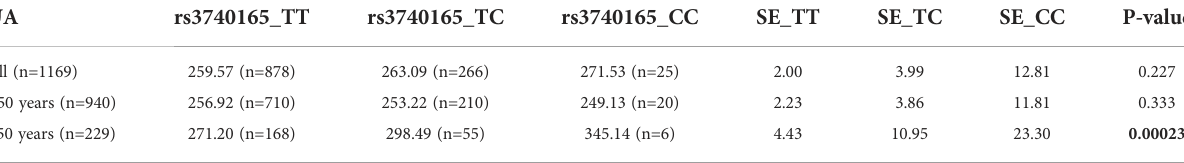
TABLE 3 The mean and standard error of serum uric acid for different genotypes after age strati fi cation.